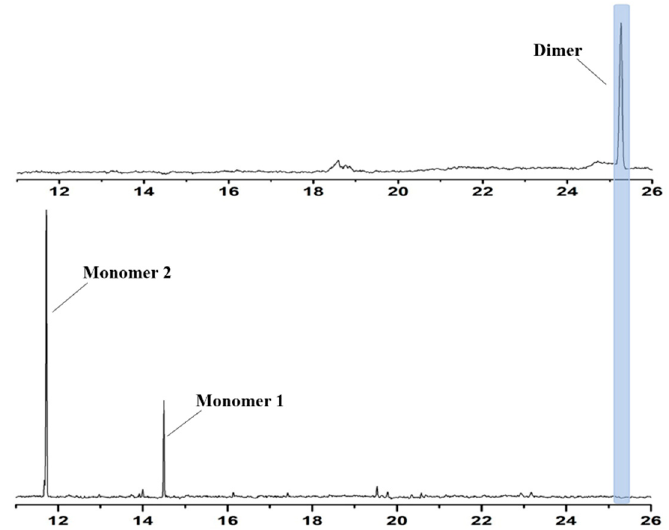
Figure 4. Gas chromatogram comparison of the lignin model compound and catalytic hydrogenolysis products over Pd-Fe 3 O 4 magnetic catalyst.